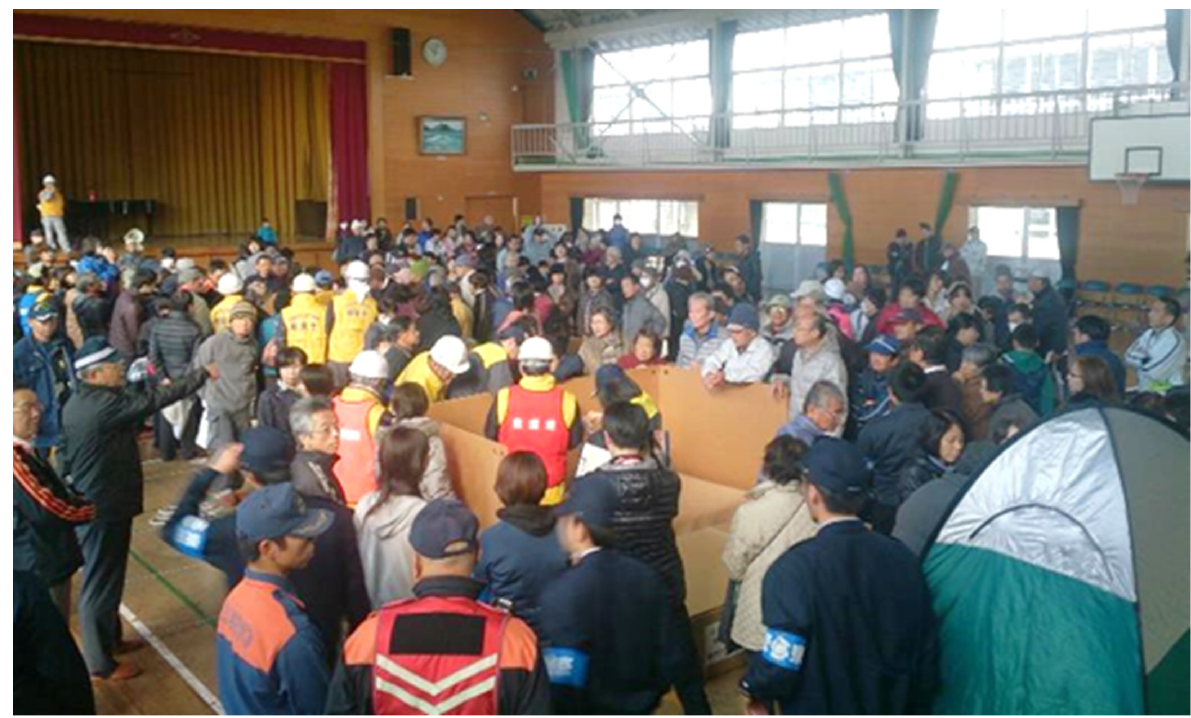
Figure 9. Disaster drills that included the participation of people with various professions from various generations [51].